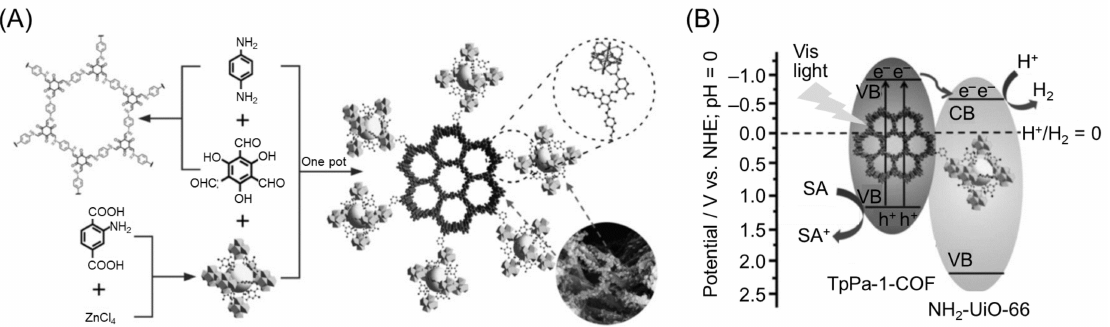
Figure 14. ( A ) Schematic illustration of the synthesis of the hybrid material composed of TpPa-1-COF (COF; upper compounds) and NH 2 -UiO-66 (MOF; lower compounds). ( B ) Schematic of mechanism of HER over the hybrid material (TpPa-1-COF:NH 2 -UiO-66 = 4:6 (optimal ratio)). SA represents the sodium ascorbate. Reproduced with permission from reference [153]. Copyright 2018